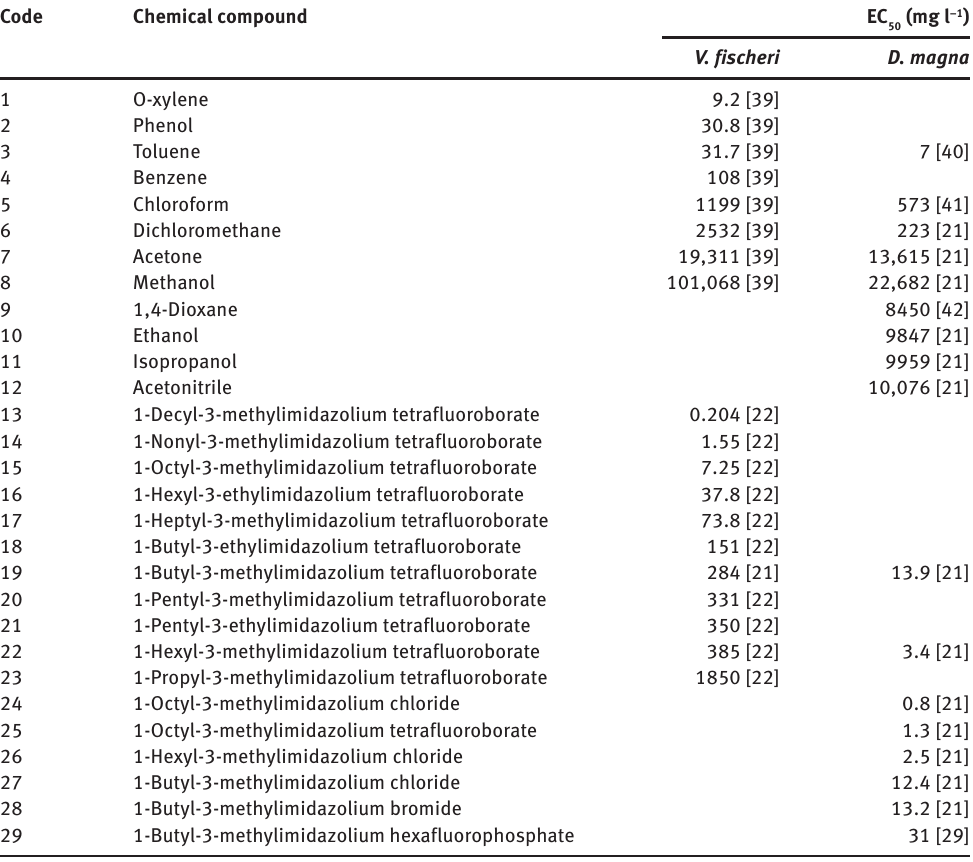
values and their codification (Figures 3 and 4) for different traditional solvents and imidazolium Table 2: EC 50 based ILs in Vibrio fischeri and Daphnia magna bioassays during 30 min and 24 h exposure, respectively. Code